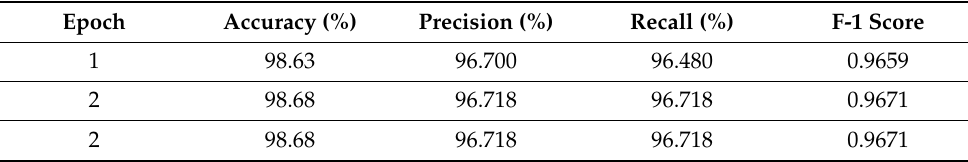
Table 11. Performance of the model with variation in the number of